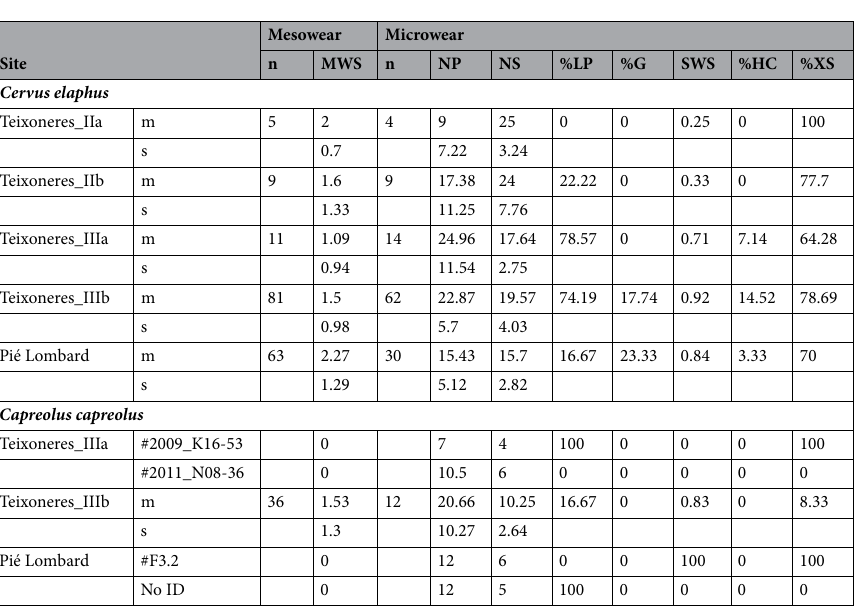
Table 1. Summary of dental meso- and microwear data for Cervus elaphus and Capreolus capreolus from Teixoneres and Pié Lombard. Abbreviations: # = identifier of the teeth; n = Number of specimens; MWS = Mesowear score; NP = Mean number of pits; NS = Mean number of scratches; %LP = Percentage of specimens with large pits; %G = Percentage of specimens with gouges; SWS = scratches width score; %HC = Percentage of specimens with hypercoarse scratches; %XS = Percentage of specimens with cross scratches; m = Mean; s = Standard